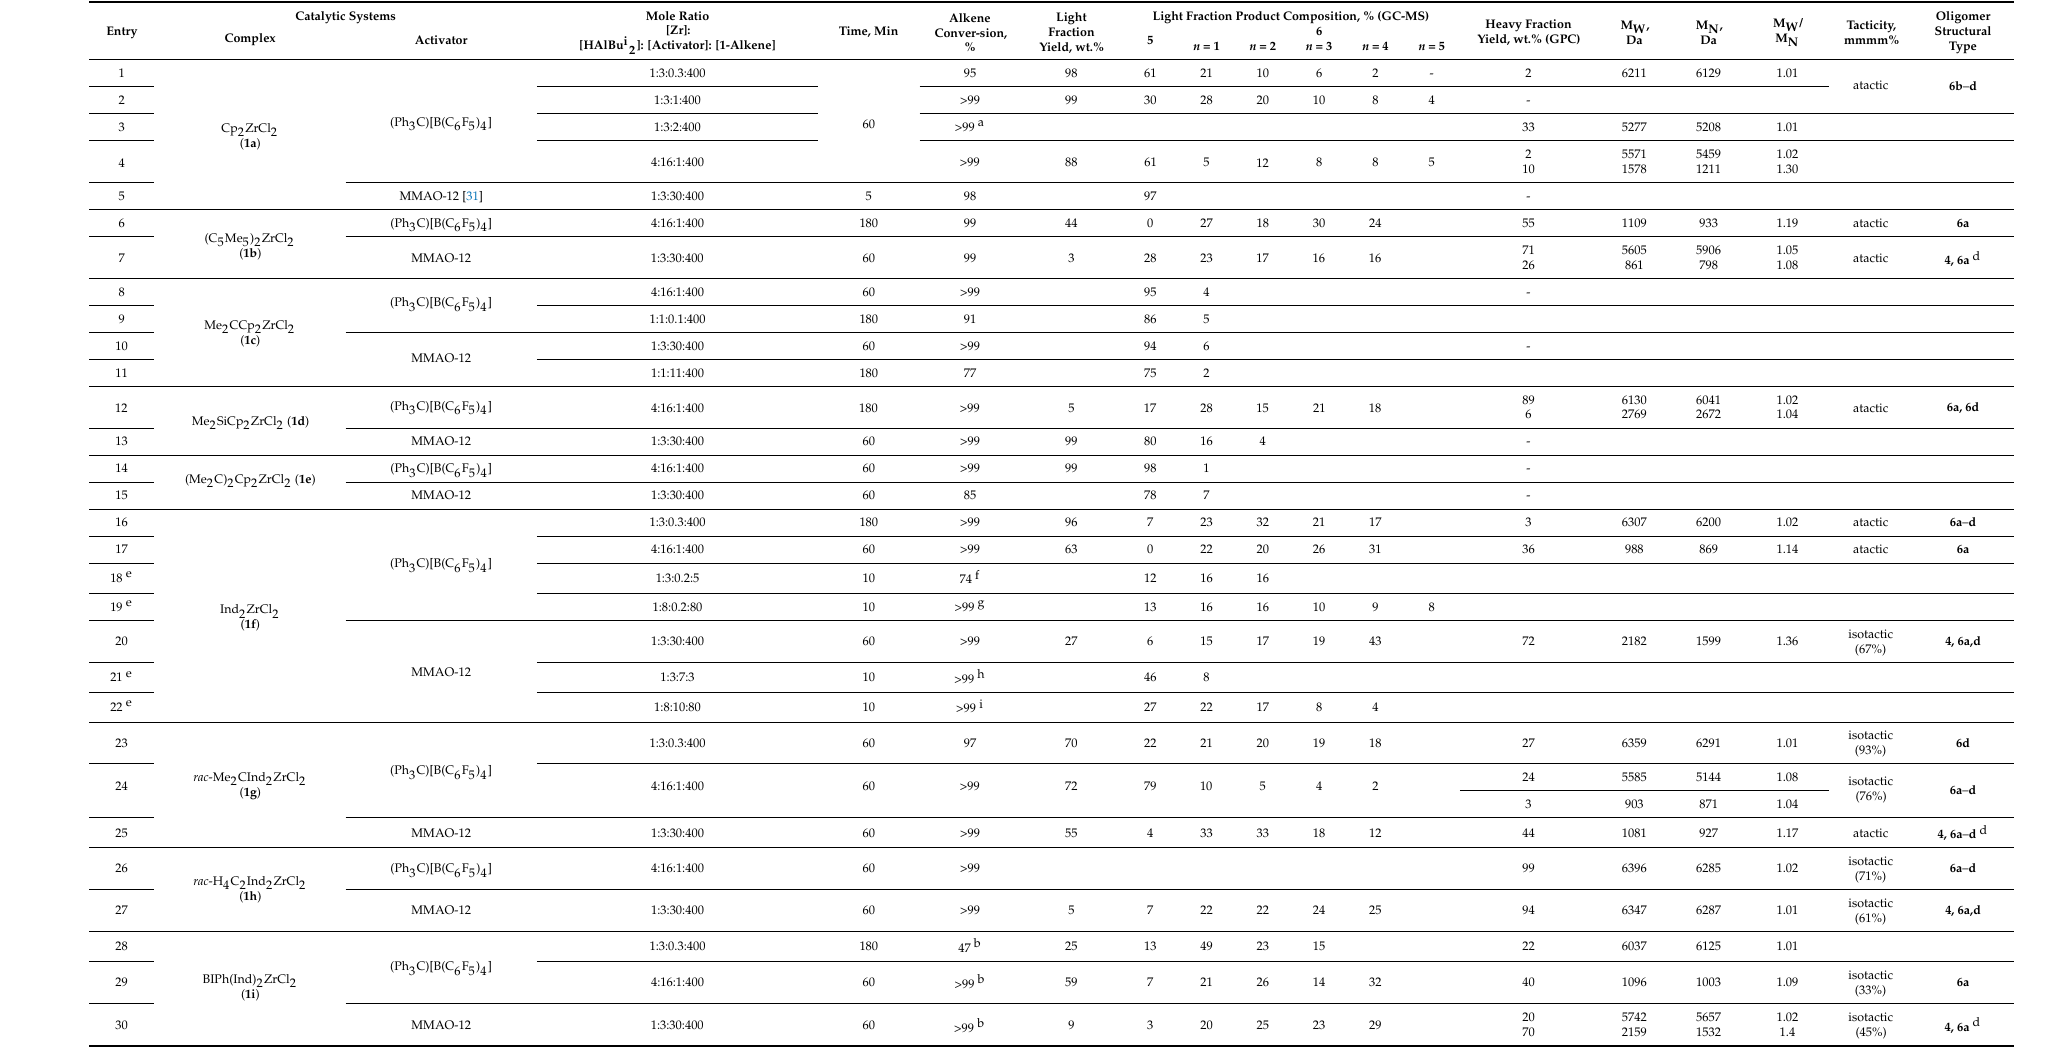
Table 1. Catalytic activity and chemoselectivity of L 2 ZrCl 2 –HAlBu i 2 –activator systems in the reaction with 1-hexene in toluene, 60 ◦